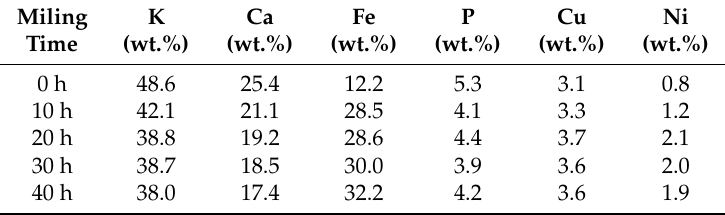
Figure 2. XRF analysis of the elemental composition of coconut shell particle at 0 h, 10 h, 20 h, 30 h, and 40 h. Table 1. Elemental composition variation of coconut shell particle with milling time.